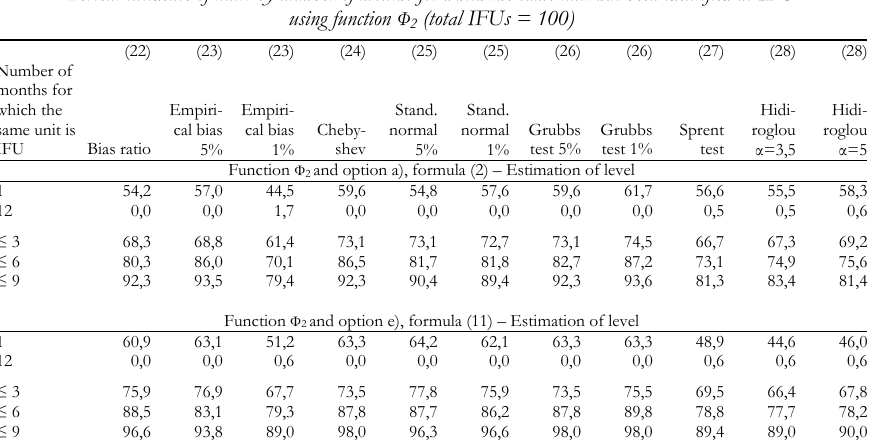
Function Ф 2 and option e), formula (11) – Estimation of level